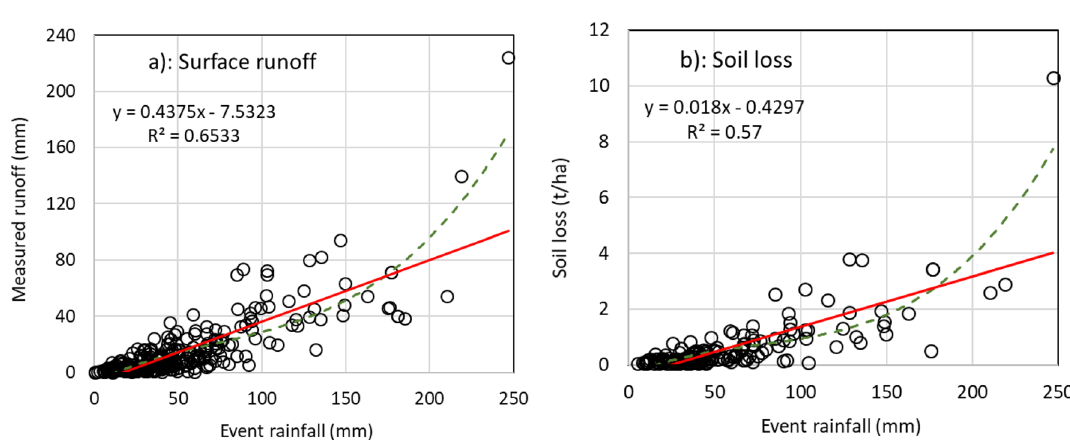
Figure 6. The relationship between rainfall events of different intensity (mm) and ( a ) runoff and ( b ) soil